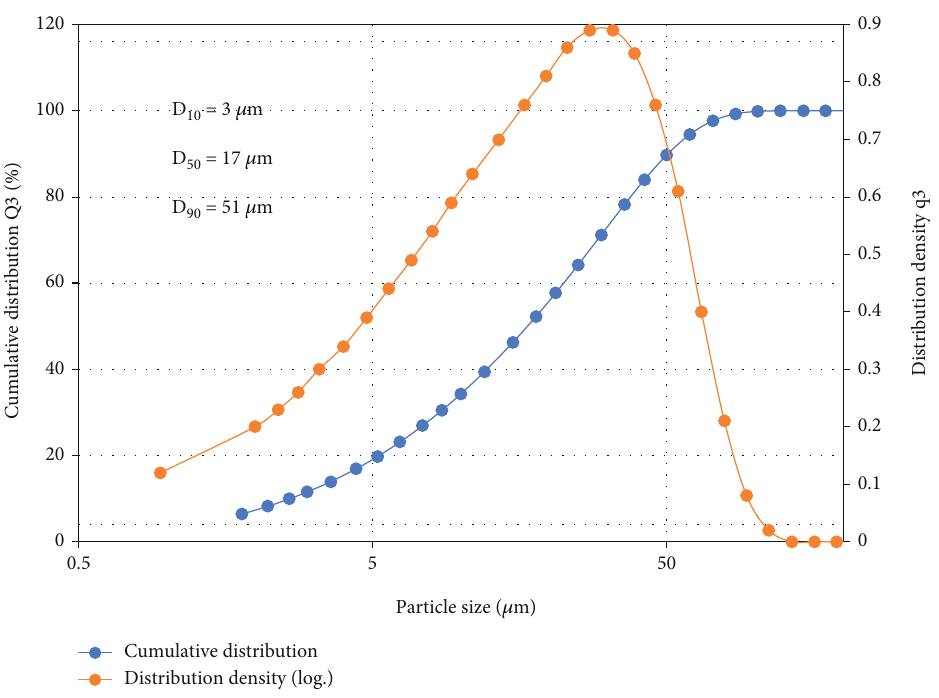
Figure 2: Particle size distribution of hematite.